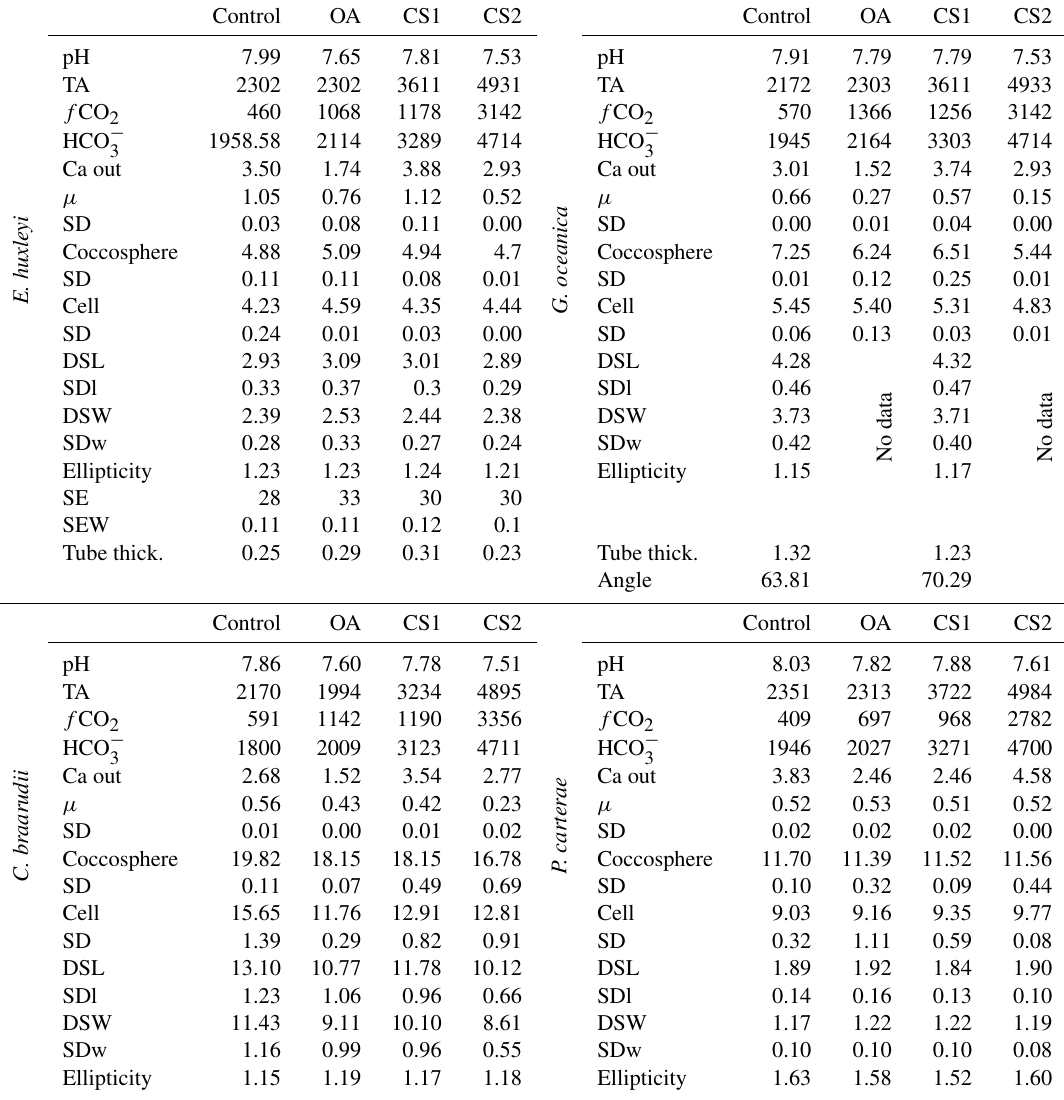
Table 6. Carbonate chemistry experiment data. Data presented are the average of three replicates. Growth rate ( µ ; in cellsd − 1 ); coccosphere and cell diameters (in µm); coccolith morphometric analyses were performed on 50 specimens for every treatment and for every replicate. The following data represent the average of three replicates: average of coccolith distal shield length (DSL; in µm) and coccolith distal shield width (DSW; in µm); ellipticity (DSL/DSW) diameter; average E. huxleyi distal shield elements number (SE) and average distal shield elements width (in µm; SEW); average E. huxleyi inner tube thickness (in µm; tube thick.) and G. oceanica bridge angle (angle ◦ ). Carbon chemistry speciation calculated as the mean of start and end values of measured pH and TA are given. SD: standard deviation. SDl and SDw refer to DSL and DSW standard